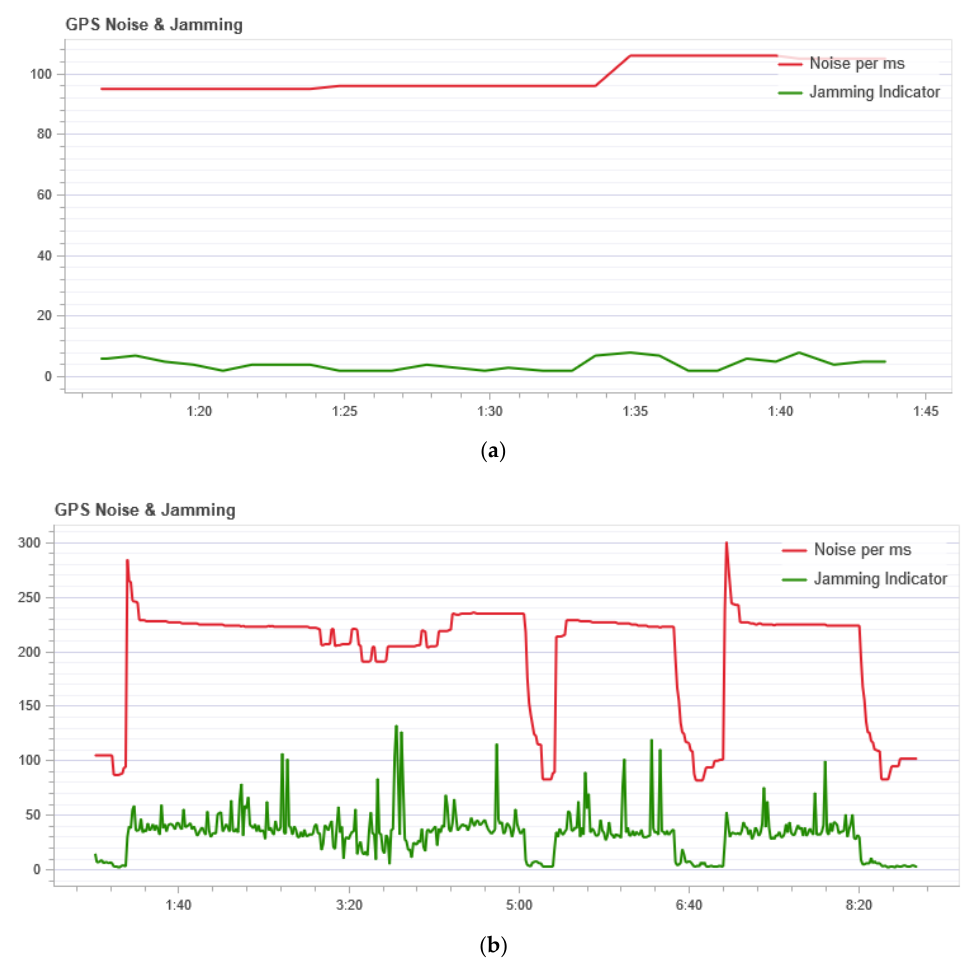
Figure 7. Indication of the level of noise affecting GPS: ( a ) In the normal mode; and ( b ) during a GPS attack.